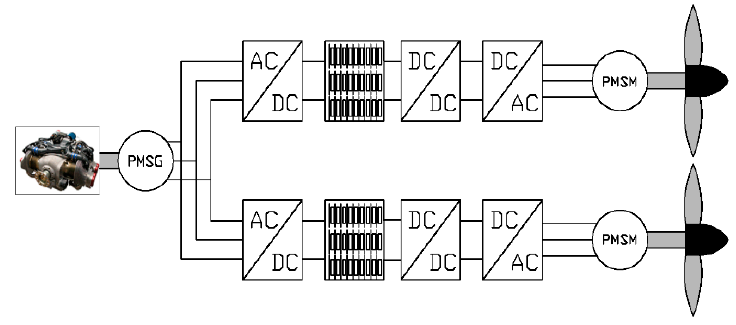
Figure 2. Variation of series-hybrid architecture of the propulsion.